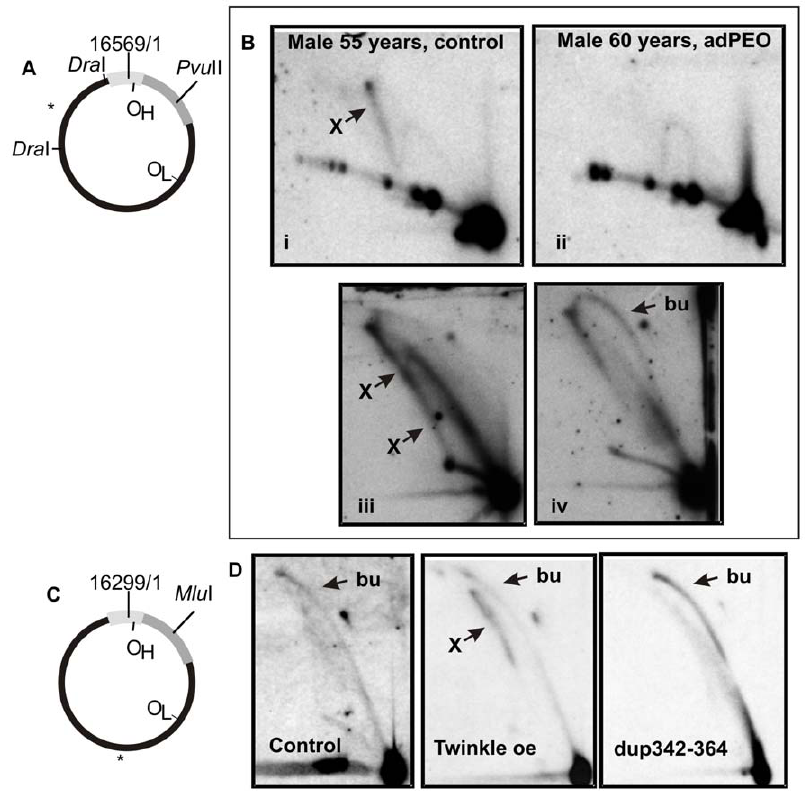
Figure 4. Theta-type mtDNA replication in heart muscle of adult adPEO patients with Twinkle dup352–364 mutation. (A) Human mtDNA showing the Dra I and Pvu II cut sites and probe locations. (B) Comparable exposures of 2D-AGE analysis of Dra I ND5 fragment (i–ii) and Pvu II (iii–iv) cut heart mtDNA from an age matched healthy control (i, iii) and adPEO patient (ii, iv). As a striking difference to the control samples, an almost complete absence of recombination intermediates (X) and a strong bubble arc (bu) in the adPEO heart muscle can be seen. (C) Mouse mtDNA showing Mlu I cut site (nt 1771) that is comparable to the human mtDNA Pvu II cut site location. (D) 2D-AGE of a Mlu I cut heart mtDNA from a control mouse, Twinkle overexpressor (oe) mouse and a mouse expressing the human Twinkle dup342-364 mutation. Whereas wild-type Twinkle enhances recombination junction formation, dup342-364 results in strong replication stalling phenotype in mouse heart. Unlike in mice, the overall intensity in the mtRIs of human adPEO patient heart is rather lower when compared to the age matched control hearts.